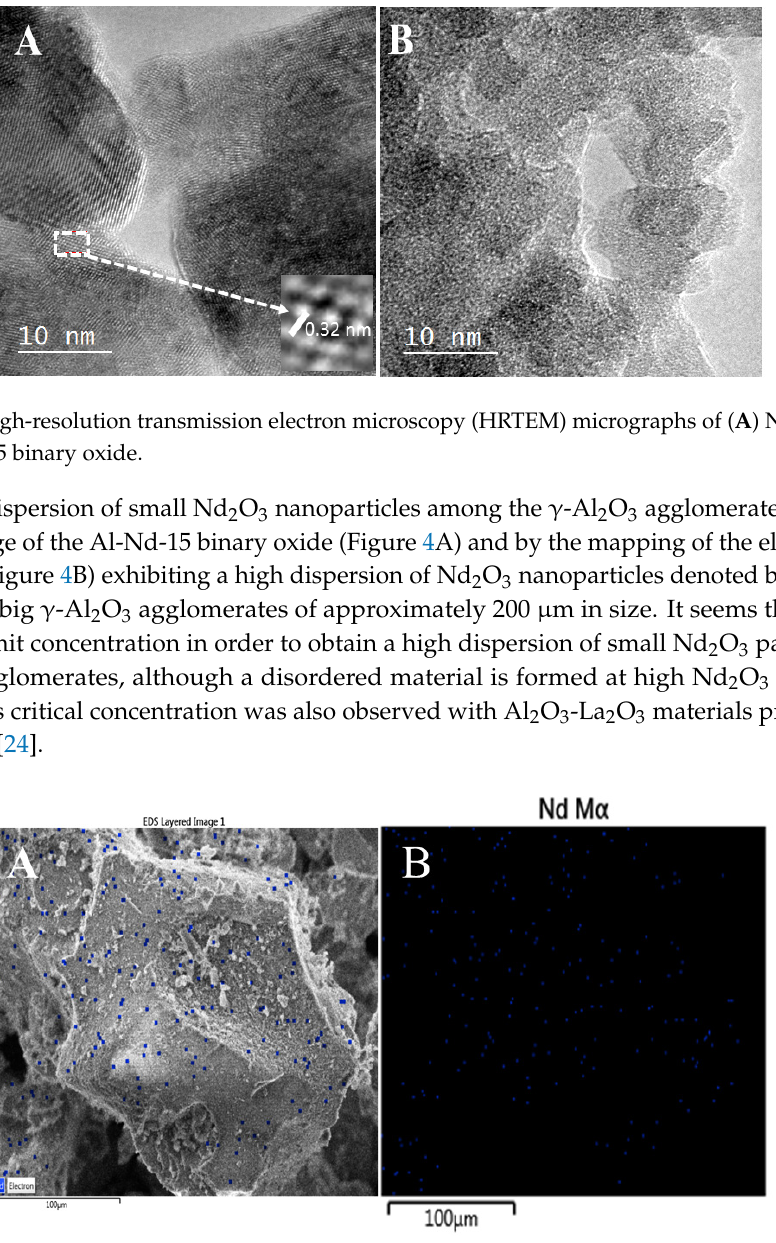
Figure 4. ( A ) EDS image of Al-Nd-15 binary oxide; ( B ) SEM mapping image of the element Nd M α of the Al-Nd-15 binary oxide.